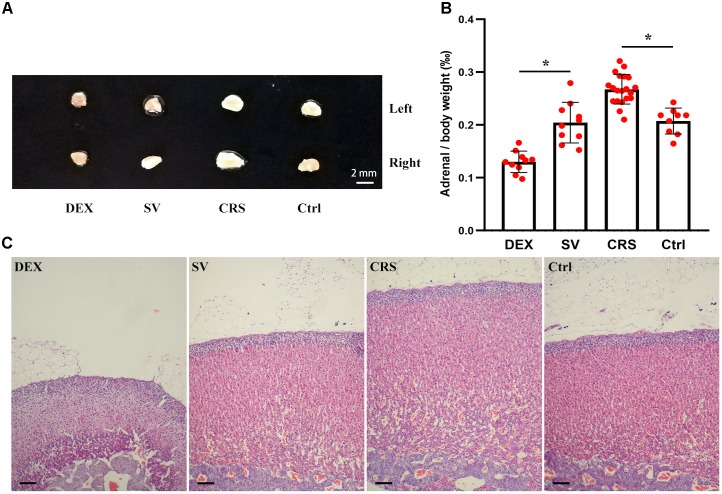
Effects of DEX injection and CRS on adrenal weight and cortical morphology. (A) The adrenal size of DEX injected mice was smaller than that of solvent (SV) injected mice, whereas the adrenal glands of CRS mice were larger than the non-restraint control (Ctrl) group. (B) Comparison of the adrenal mass to body weight ratio (adrenal index). The data showed that the adrenal index of mice injected with DEX was significantly lower than that of mice injected with solvent. The adrenal index of CRS mice was significantly higher than that of the control group. Data were shown as means ± SEM, ∗
p < 0.01. (C) The HE staining sections of mouse adrenal cortex. The CRS mice had hyperplasic adrenal cortex (about 68 cell layers or 1,000 μm in thick, compared to 54 cell layers or 750 μm for the normal control). On the contrary, the adrenal cortex of DEX injected mice was only about 37 cell layers or 500 μm in thick, much thinner than the solvent injected mice. Scale bar = 100 μm.